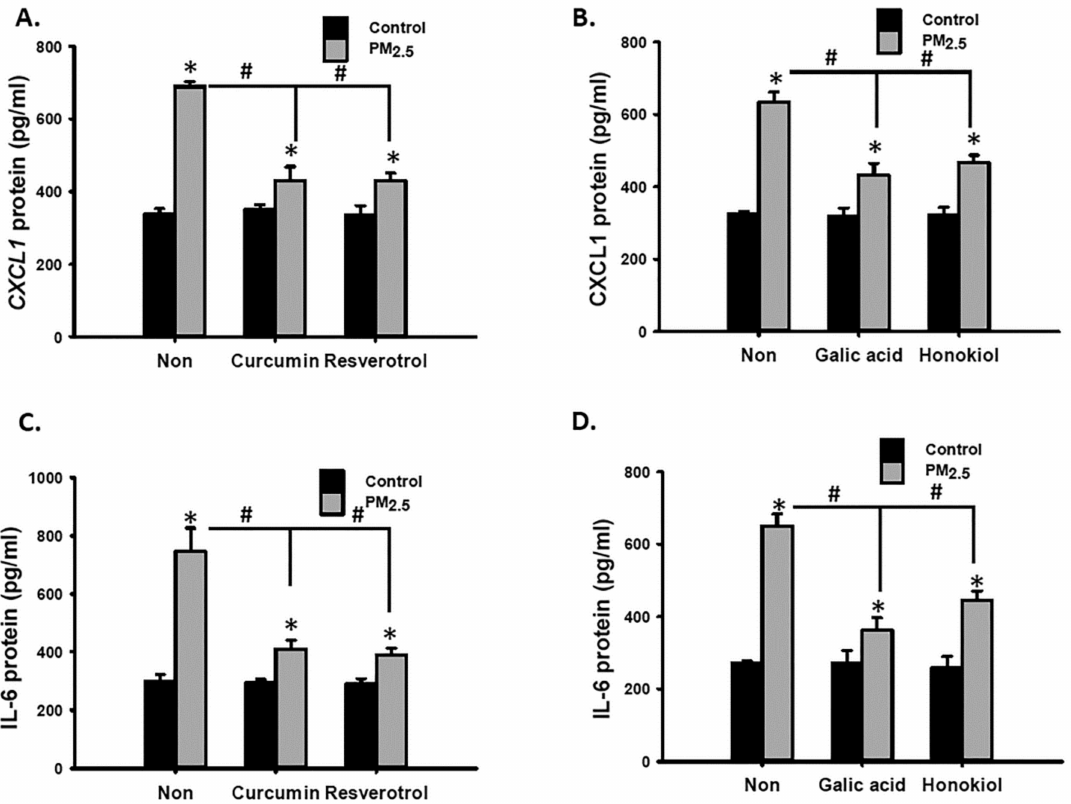
Figure 9. Polyphenolic compounds prevented PM 2.5 -induced inflammatory cytokine secretion in MVSMCs. MVSMCs were treated with d 2 H 2 O or 25 µ g/mL PM 2.5 or PM 2.5-10 with and without 5 µ M curcumin, resveratrol, GA, or honokiol. ( A , B ) CXCL1 protein concentrations in the media were quantified. ( C , D ) IL-6 protein concentrations in the media were quantified. The results are presented as the mean ± SD for three independent experiments. * p < 0.05, compared with d 2 H 2 O-treated cells. # p < 0.05, compared with herbal compound-treated